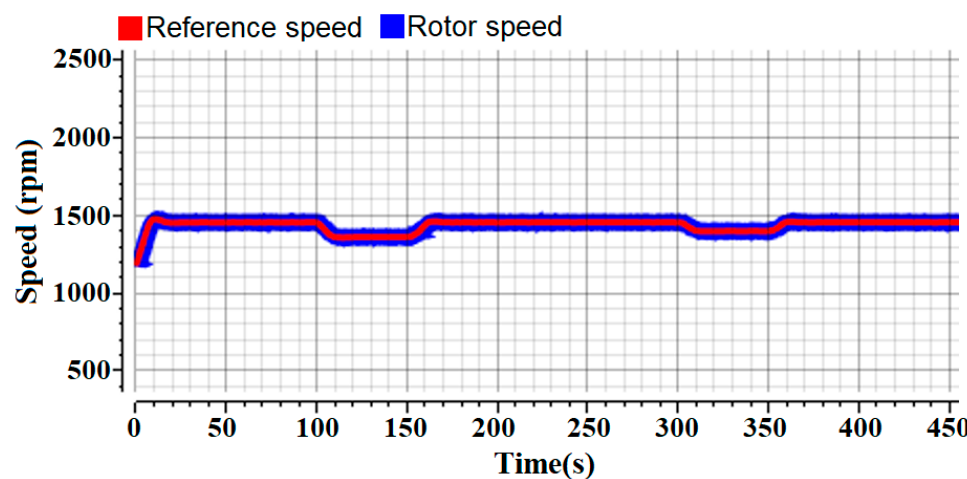
Figure 24. Reference and measured speed of the motor (experimental results).